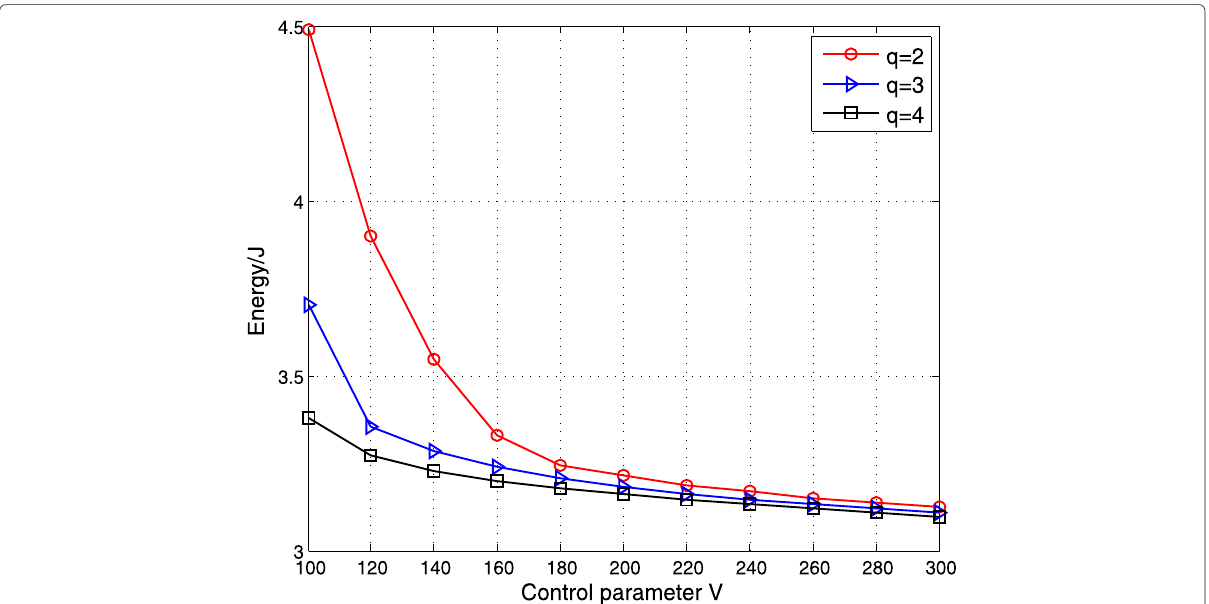
Fig. 7 The average energy consumption versus the control parameter V with different q